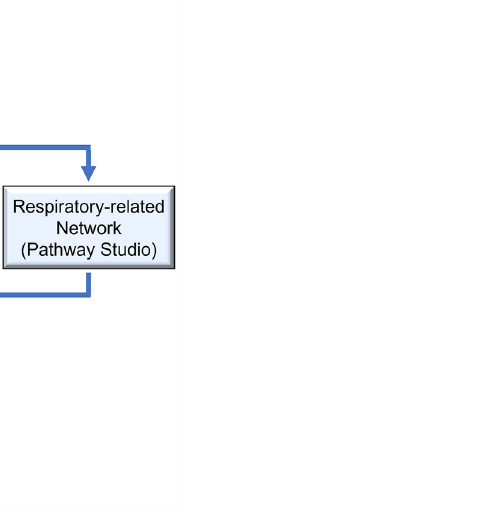
Figure 1. Flow chart of the steps used in this